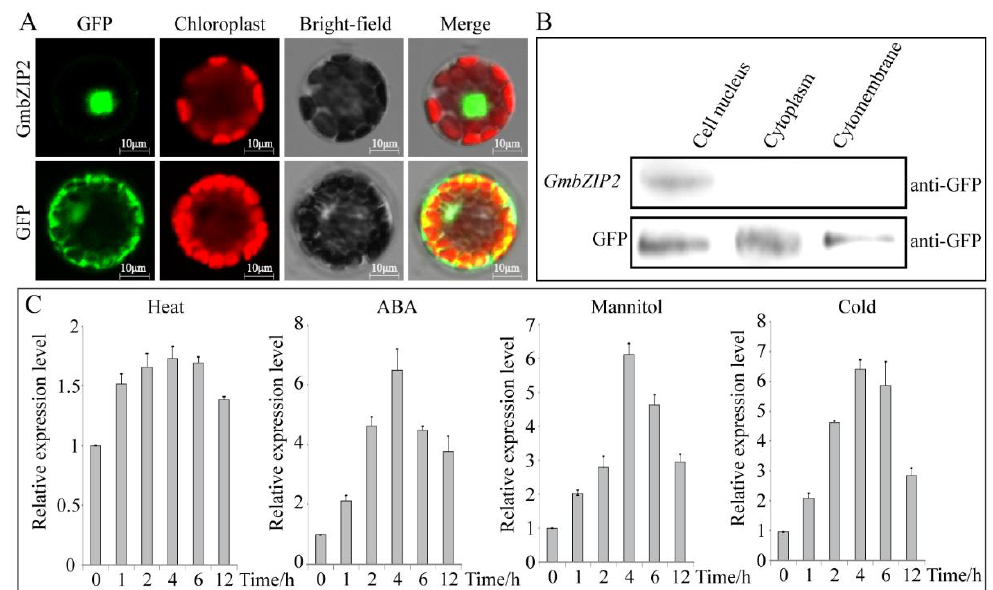
Figure 7. GmbZIP2 subcellular localization and expression patterns under different stresses. ( A ) Subcellular localization analysis of GmbZIP2 protein. The scale bar was shown by 10 μm. ( B ) Western blot detection analysis of GmbZIP2 protein subcellular localization. ( C ) The expression patterns of GmbZIP2 under different stresses. Vertical bars in C indicate ± SE of three replicates. 2.7. Overexpression of GmbZIP2 in Arabidopsis Improved Drought and Salt